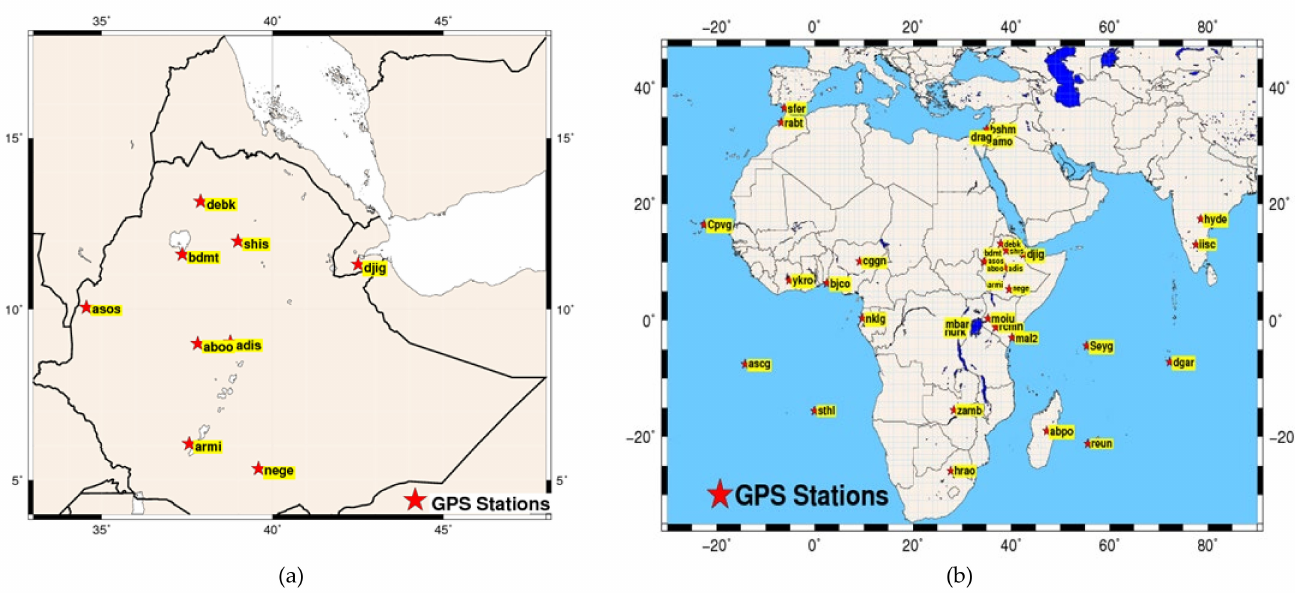
Figure 1. Maps of GPS stations in this study: ( a ) 8 Ethiopian GPS stations and the station Djibouti (DJIG) for which the PWV was retrieved and analyzed and ( b ) the entire network of stations used here for the processing of the zenith total delays (ZTD) at the Ethiopian GPS stations and DJIG. In total, we used the data from 26 IGS stations surrounding the country (including DJIG) and 8 Ethiopian stations (ADIS being also an IGS site)